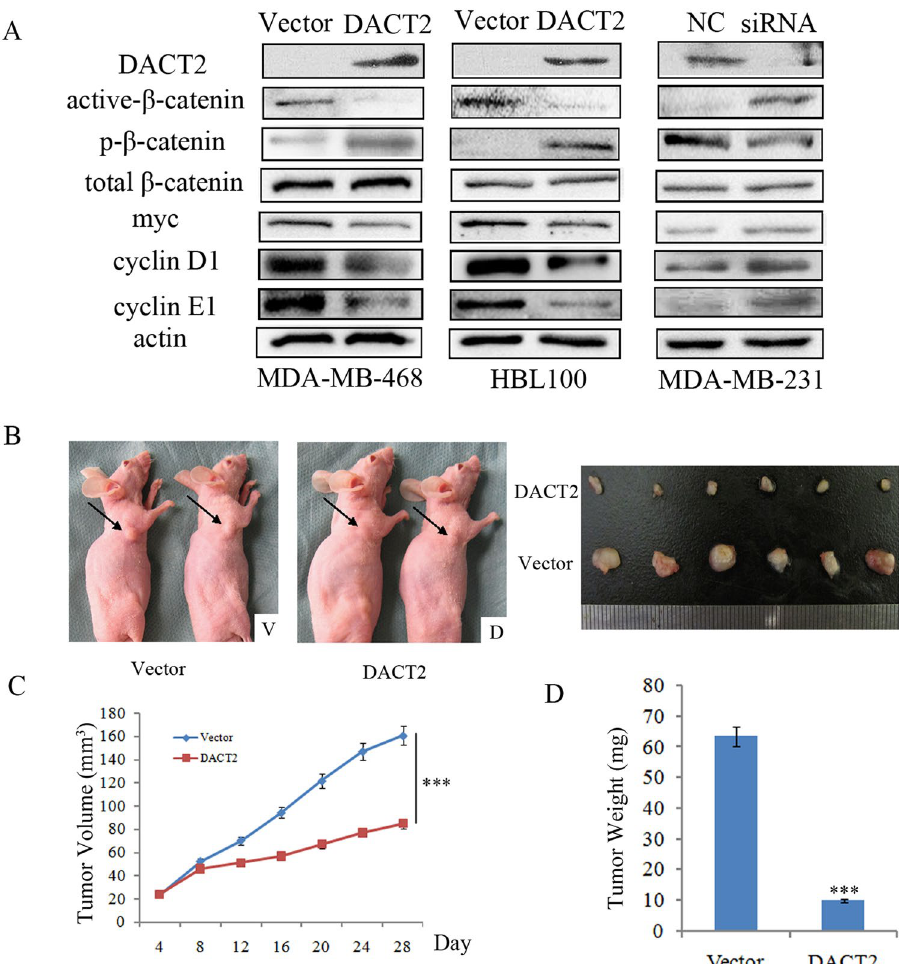
Figure 5. The role of DACT2 in Wnt/ β -catenin signaling and the effects of DACT2 on breast cancer cell line xenografts ( A ) Active- β -catenin, p- β -catenin, total β -catenin, myc, cyclin D1 and cyclin E1 were detected by western blot in DACT2 unexpressed (vector) and re-expressed (DACT2) MDA-MB-468 and HBL100 cells. The results were validated by knocking down DACT2 in MDA-MB-231 cells. ( B ) Representative results of DACT2 re-expressed and unexpressed MDA-MB-468 cell xenografts in mice. V: control group; D: DACT2 re-expressed breast cancer cells group ( C ) Tumor growth curves of DACT2 re-expressed and unexpressed MDA-MB-468 cell xenografts. *** P < 0.001 ( D ) The average weights of DACT2 re-expressed and unexpressed MDA-MB-468 cell xenografts. *** P <